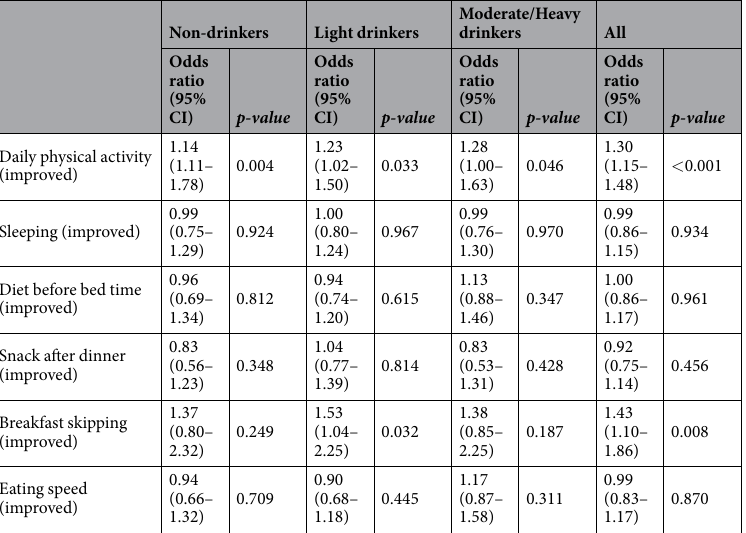
Table 3. Associations between improved hepatobiliary enzyme abnormality and changes in lifestyle factors among 18,070 participants through 2011–2012 to 2013–2014. CI, confidence interval. Adjusted for age, sex, body mass index, smoking, evacuation, and alcohol